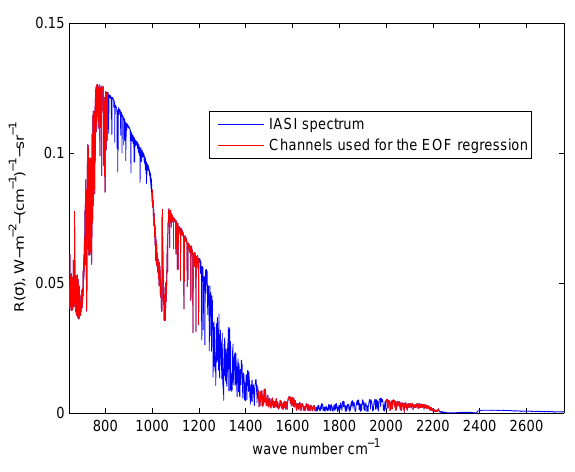
Figure 4. Example of IASI spectrum, R ( σ ) , with the indication of the 3,385 selected for the